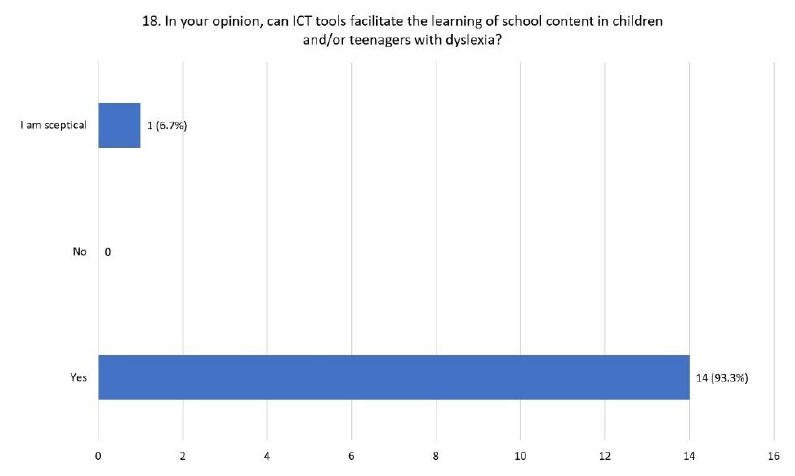
Figure 7. Distribution of responses to question 18.